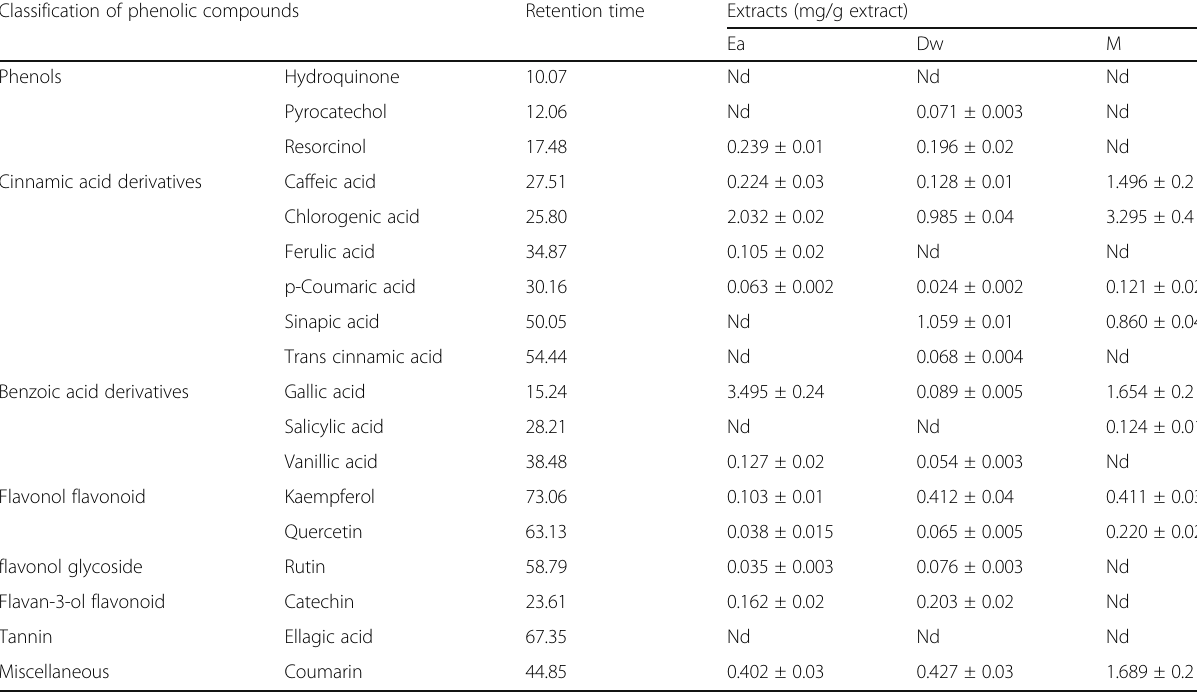
Table 1 Phenolic composition of methanol (M), water (Dw) and ethyl acetate (Ea) extracts of A. bracteosa Classification of phenolic